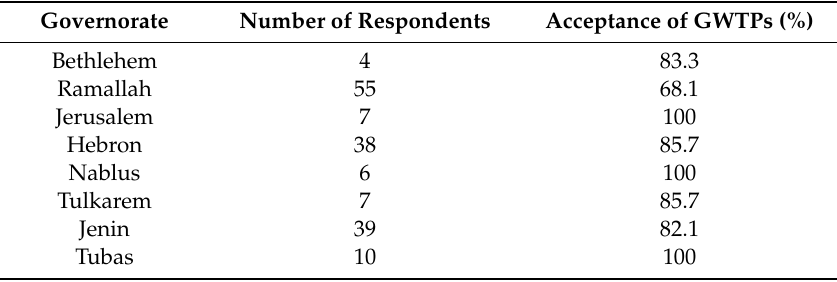
Table 2. Acceptance of GWTPs for reuse in irrigation per governorate.